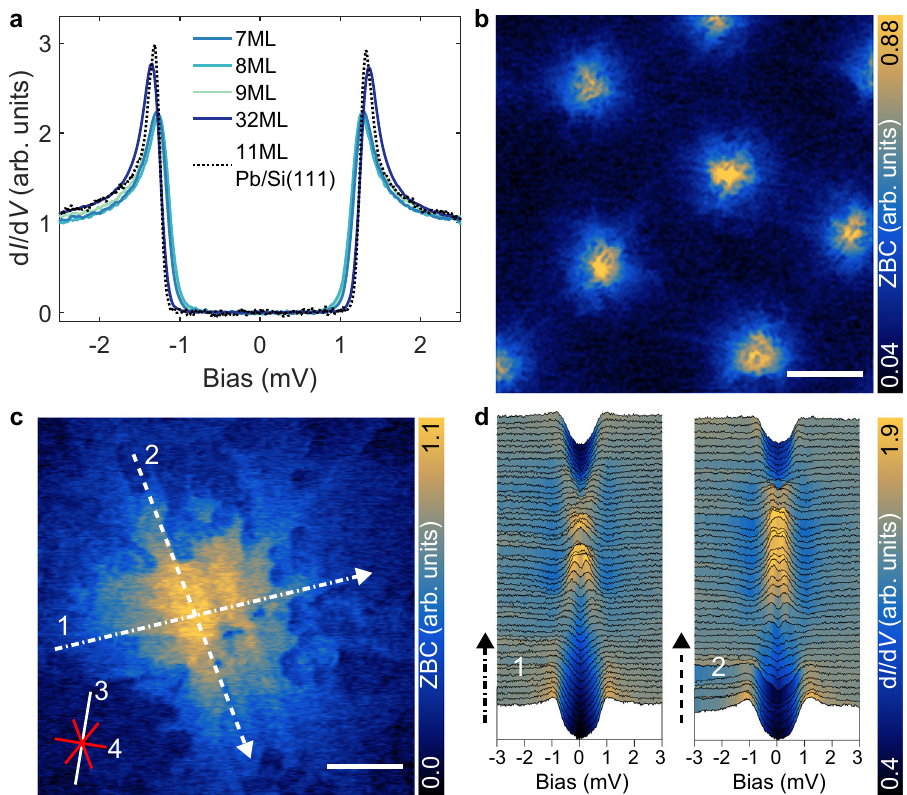
Fig. 2 Hybrid superconducting gap and anisotropic vortex structure. a d I /d V spectra measured at T = 30 mK on different layer thicknesses of the Pb fi lm grown on BP, plotted together with the spectrum measured on 11 ML Pb grown on Si(111). For comparison, all the spectra are normalized at V = 3 mV. (Pb/ BP: V stab = 5 mV, I stab = 200 pA, V mod = 50 μ V; Pb/Si(111): V stab = 5 mV, I stab = 200 pA, V mod = 20 μ V). b Zero bias conductance (ZBC) map measured on as grown 7.3 ML Pb fi lm at T = 30 mK and B ? = 50 mT showing the Abrikosov vortex lattice (scale bar = 100 nm). Image in c shows ZBC map of a single vortex (scale bar = 20 nm). Solid lines in the bottom left indicate in-plane crystallographic directions for BP (white line along zig-zag direction [010] denoted by 3) and Pb (red lines along atomic rows of Pb(111) lattice denoted by 4). Imaging parameters for b and c : V stab = 10 mV, I stab = 10 pA, V = 200 μ V, Δ z = − 80 pm. d d I /d V spectra measured across the vortex in two directions (1,2) along the lines through the vortex in c each of 84 nm in mod length. ( V stab = 5 mV, I stab = 200 pA, V mod = 50 μ (Fig. 2d). The d I /d V spectra measured along one of the extended stripes (along [110] of the Pb lattice) shows a small splitting of the zero bias peak away from the center and extends over several tens of nanometers (direction 2) before abruptly merging into the coherence peaks. However, d I /d V spectra measured in a nearly perpendicular direction (direction 1) show a splitting of the zero bias peak which smoothly merge into the coherence peaks above 10 nm. We chose these two directions for the given vortex such that the spectra were taken on a fl at area with the same thickness, and to avoid the island edges. We note that vortices were observed on all fi lms, while the formation of a clear Abrikosov lattice was only seen on thin fi lms with a suf fi ciently low defect density. A comparison between a zero bias conductance map and the topography shows no strong correlation. However, a slight distortion of the Abrikosov lattice (especially at B ? = 80 mT) indicates weak pinning of the vortices (Supplementary Fig. 7). Based on magnetic fi eld dependent spectroscopy measurements, we (cid:2) 280 mT and a coherence length of ξ ≈ 30 nm extract H C2 (Supplementary Fig. 7). We note that the value of ξ is extracted from a radially averaged pro fi le over the given vortex. A radially dependent analysis of the vortex would require statistics over more vortices with comparable structure, based on a detailed study of a fl at fi lm with one layer thickness on the order of the length scale of the Abrikosov lattice constant.